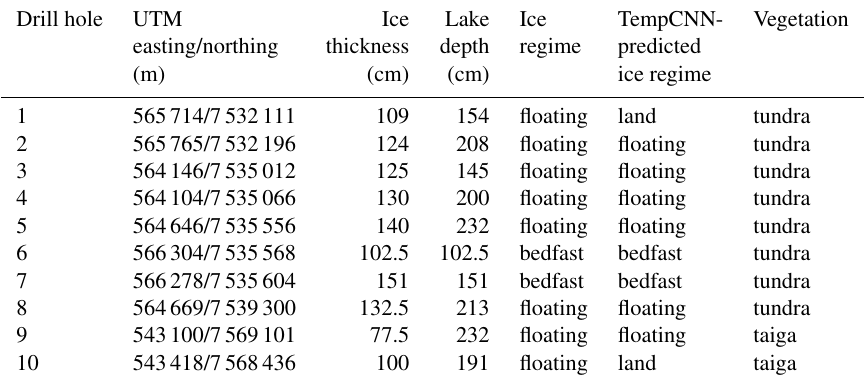
Table 3. Field data collected in the OCF in April 2009. For each of the 10 locations, UTM coordinates, ice thickness, lake depth, and ice regime recorded in the field are matched with the TempCNN output (bedfast, floating, land) and vegetation type (tundra or taiga).